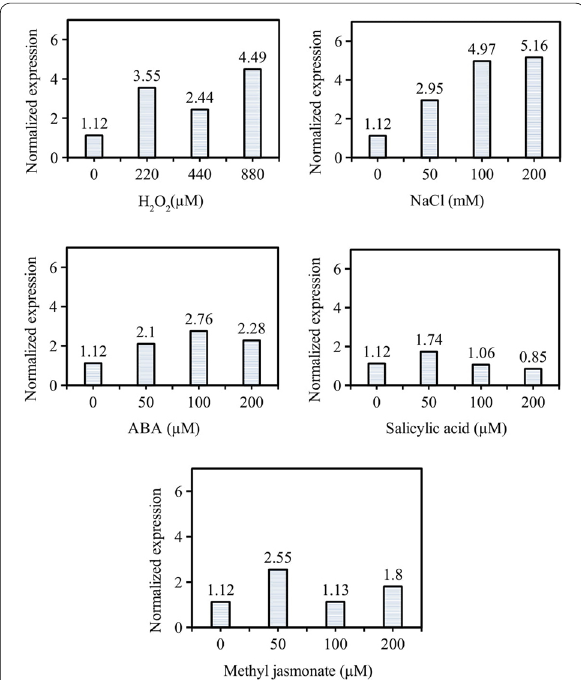
Fig. 1 Miraculin gene expression in transgenic callus under abiotic stress treatments. Data represent mean lowercase letters indicate statistically significant differences at P < 0.05 (Duncan’s multiple range test)